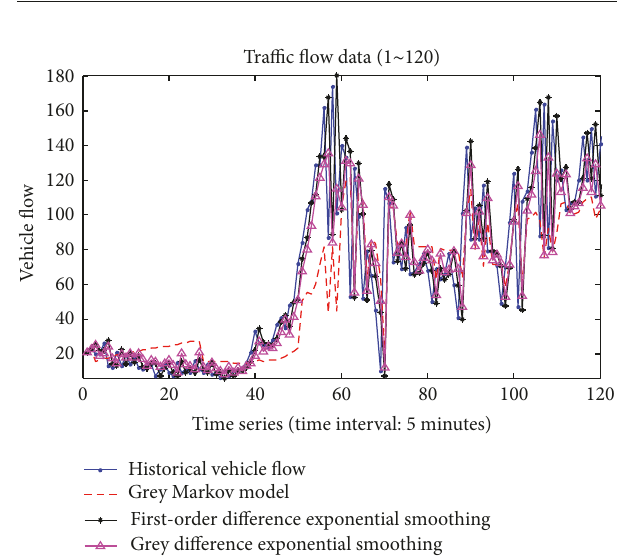
Figure 8: Fitting curves between model predictive values and actual test values (the first 120 data points).